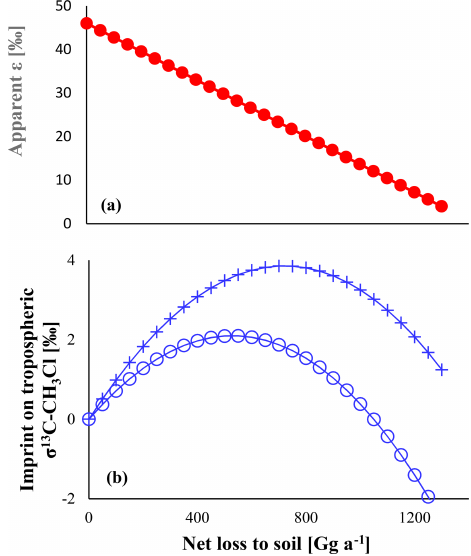
Figure 4. Panel (a) shows the apparent ε of the soil sink versus the sink strength. Panel (b) shows the resulting effect on tropospheric δ 13 C. Crosses show the pure effect, e.g. in the absence of any other fractionating sink. Open circles show the resulting effect with an ε of − 11 . 2‰ assigned to the OH sink. Total losses were assumed to be fixed at 4010Gga − 1